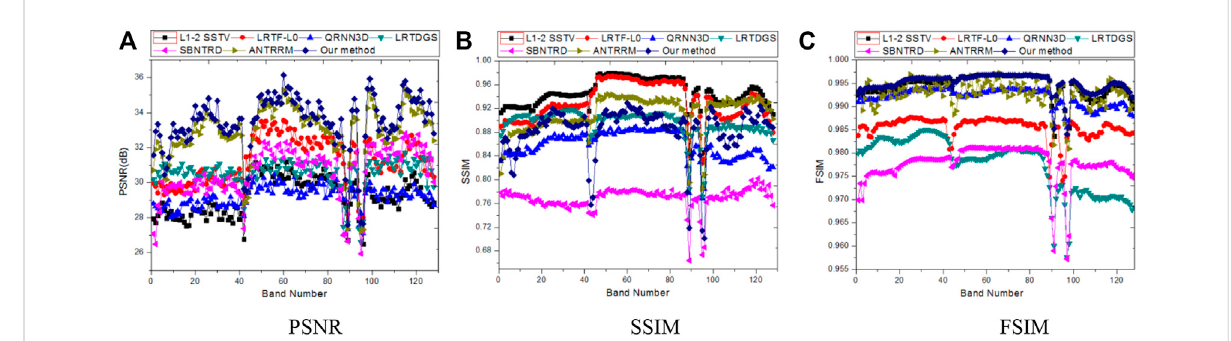
FIGURE 8 The comparative performance of different methods in terms of PSNR, SSIM, and FSIM under Case 2 on WDC Mall. (A) PSNR, (B) SSIM, (C) FSIM.